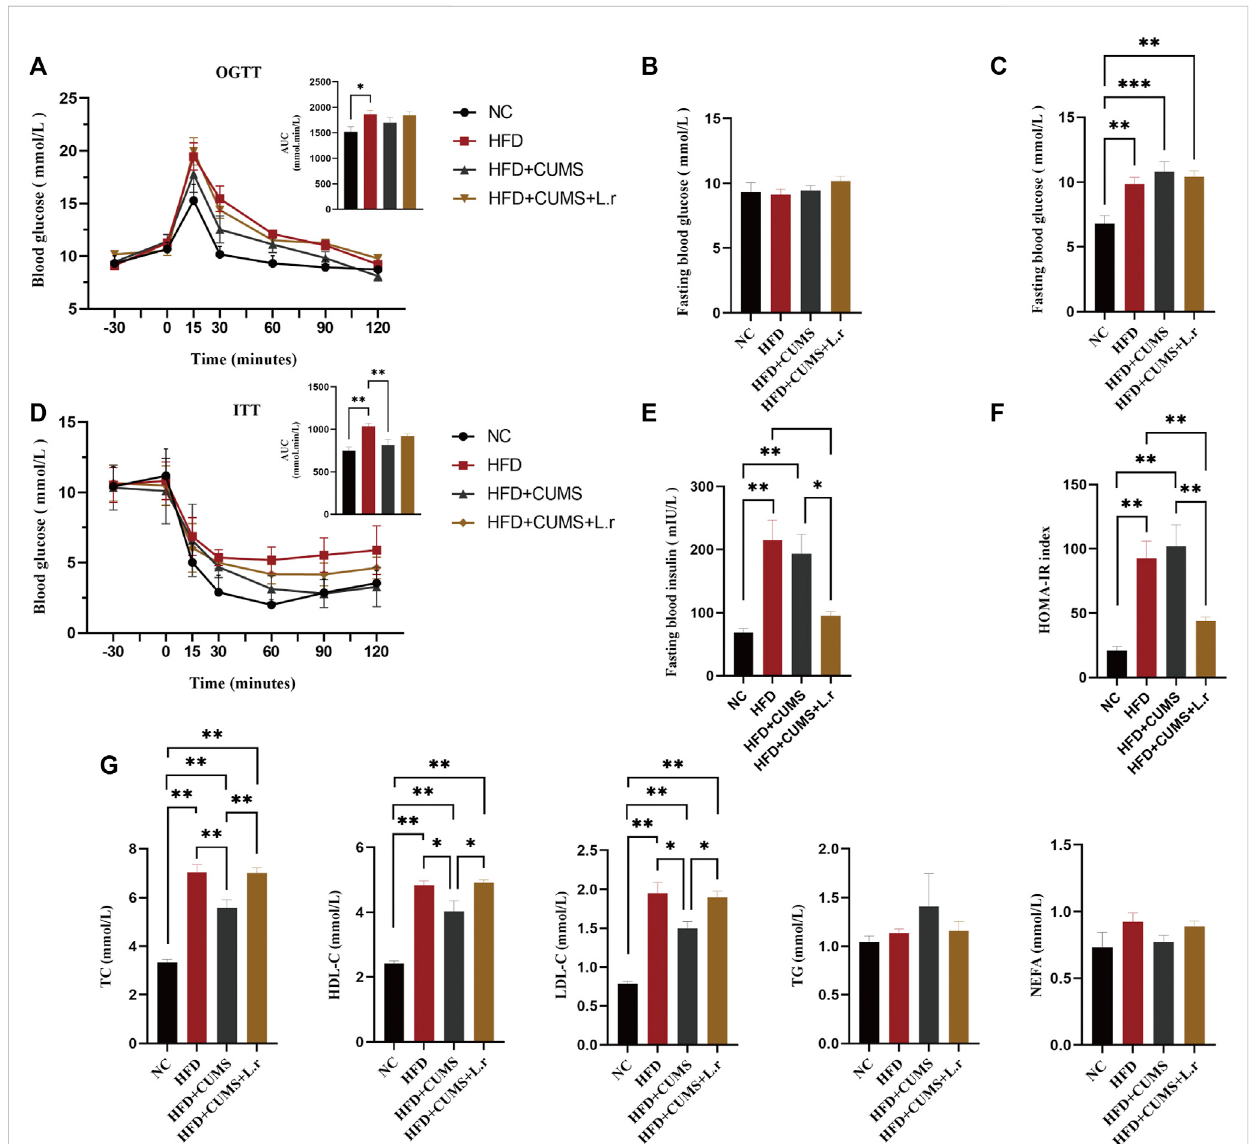
Gavagedwith Lactobacillusreuteri resistedthedevelopmentofdiabetesandimprovedthedyslipidemia( n =6 – 8/group). (A) Oralglucose tolerance test. (B) Fasting 5-h blood glucose. (C) Fasting 12-h blood glucose. (D) Insulin tolerance test. (E) Fasting blood insulin. (F) Homeostasis model assessment (HOMA)-insulin resistance (IR) index. (G) Serum Lipid Indicators. Data are shown as the mean ± SEM. * p < 0.05, ** p < 0.01 (Statistical comparisons between the two groups were performed using the two independent samples t -test. Comparisons between multiple groups were performed using One-way ANOVA and Tukey